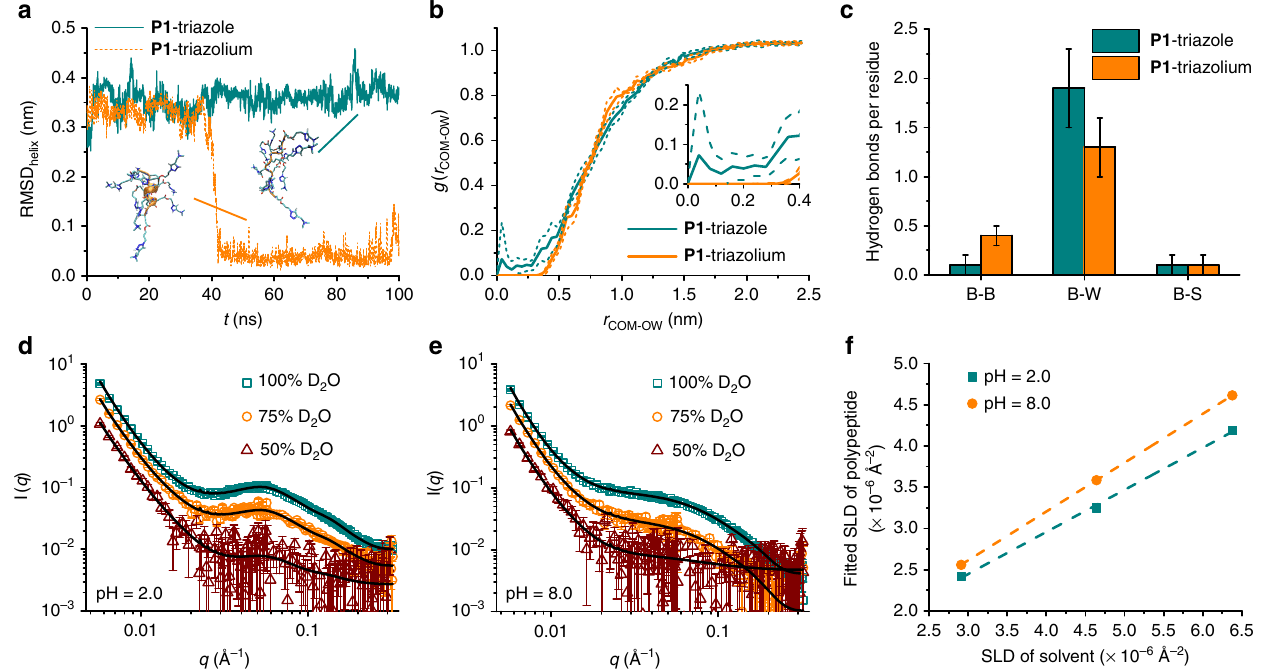
Fig. 4 Molecular dynamics simulations and small angle neutron scattering tests of P1 . a Time trace of the root mean squared deviation of the backbone C α atoms from an ideal α -helix (RMSD helix ). Representative snapshots of each polypeptide were visualized in VMD 52 , where water molecules have been removed for clarity of viewing. b Radial distribution function between the polypeptide backbone center of mass and the water solvent O atoms, g ( r COM- fi nal 50 ns of the simulation employing a bin size of 0.04 nm. The thin dotted lines fl anking each curve denote OW ), for P1 -triazole and P1 -triazolium over the standard errors estimated by block averaging over fi ve 10 ns blocks. The inset shows an enlarged view of the water depletion zone. c Histogram of the number of H-bonds per residue within the polypeptide backbone (B – B), between the backbone and water (B – W), and between the backbone and side-chain triazole/triazolium (B – S). Error bars are standard deviations about the mean of the distributions of H-bonds per residue. Each distribution contains 1000 data points. d , e Scattering patterns of P1 in different D 2 O/H 2 O solvents at pH 2.0 ( d ) and pH 8.0 ( e ). Error bars represent standard deviations derived from neutron counts. f Linear regression of the fi tted scattering length density (SLD) of the polypeptide and the SLD of the